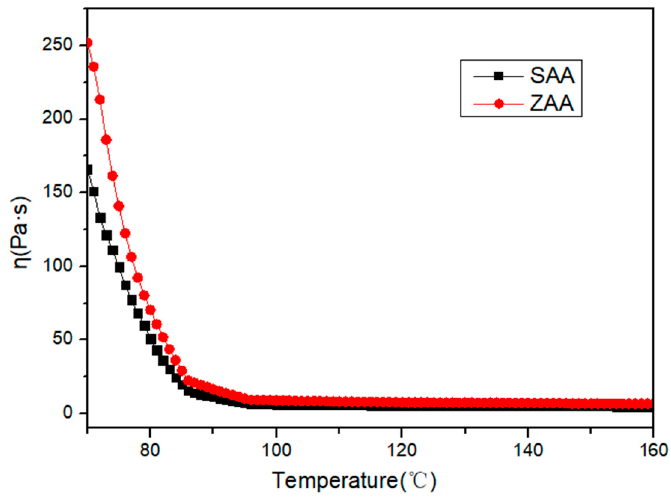
Figure 3. The viscosity-temperature relation of SAA and ZAA.